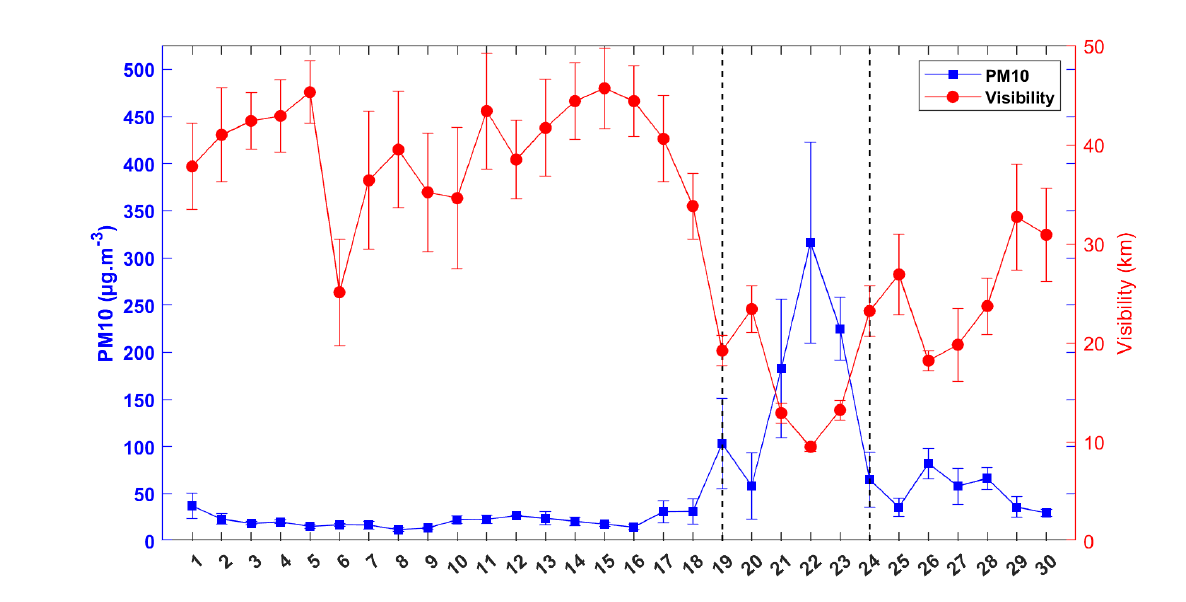
Figure 7. Daily average of PM 10 and visibility data in GPE for June 2020. Standard deviations are illustrated by the whiskers and the vertical dotted lines indicate the passage of the